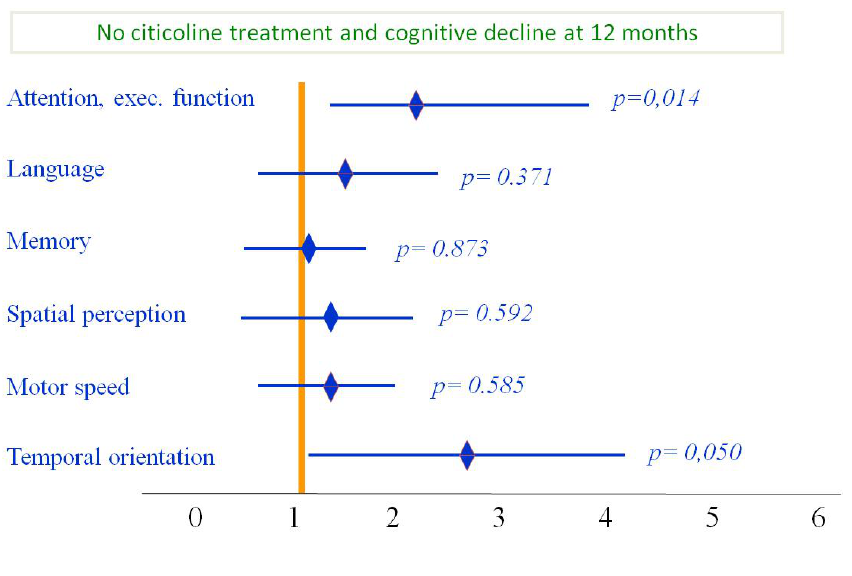
Figure 5. Functional status during six month follow-up: Subjects treated with citicoline had improvement on all cognitive domains; however, improvement was statistically significant only for attention/executive function and temporal orientation. Modified from Álvarez-Sabín et al .